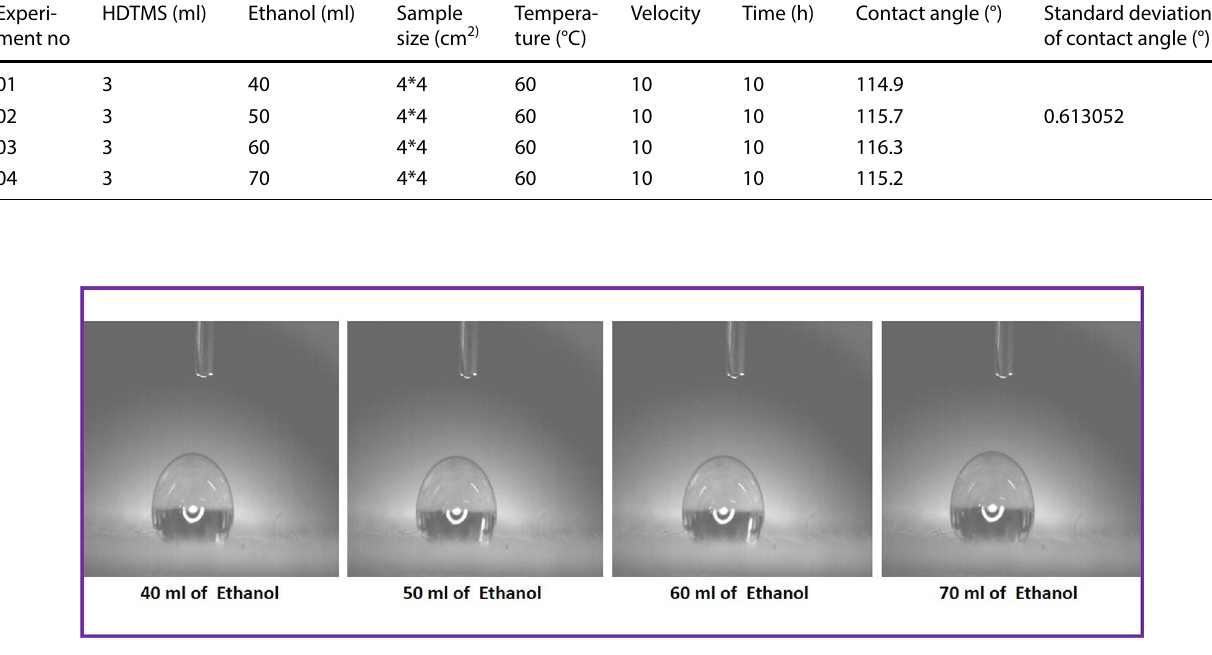
Fig. 12 Different contact angles at different amounts of